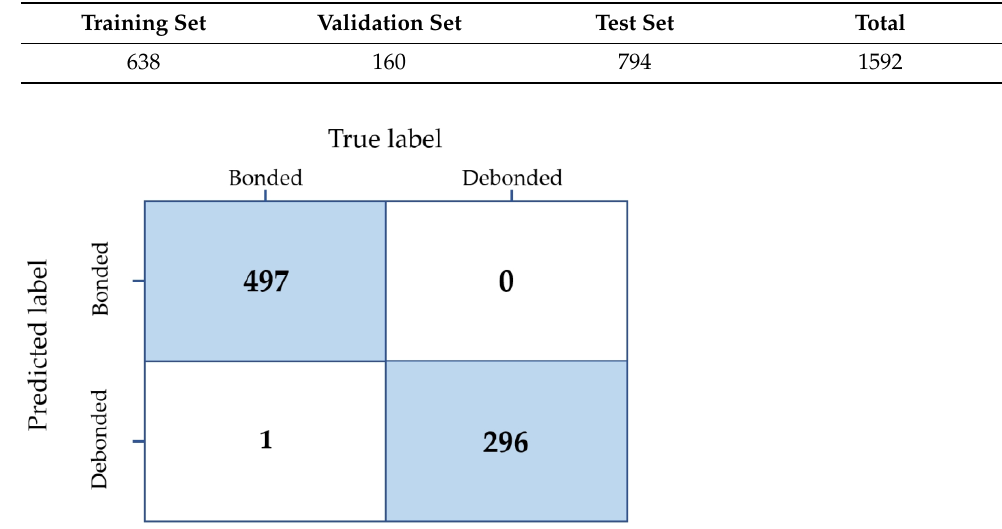
Figure 8. Confusion matrix of the classification results.